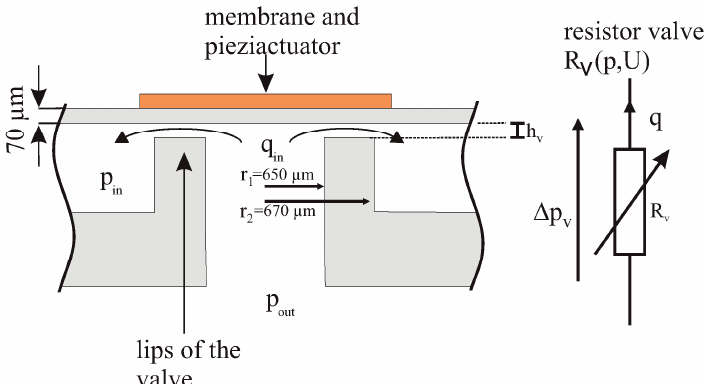
Figure 6. Dimensions of the valve. To calculate the fluidic resistance of the valve h v , r 1 and r 2 have to be